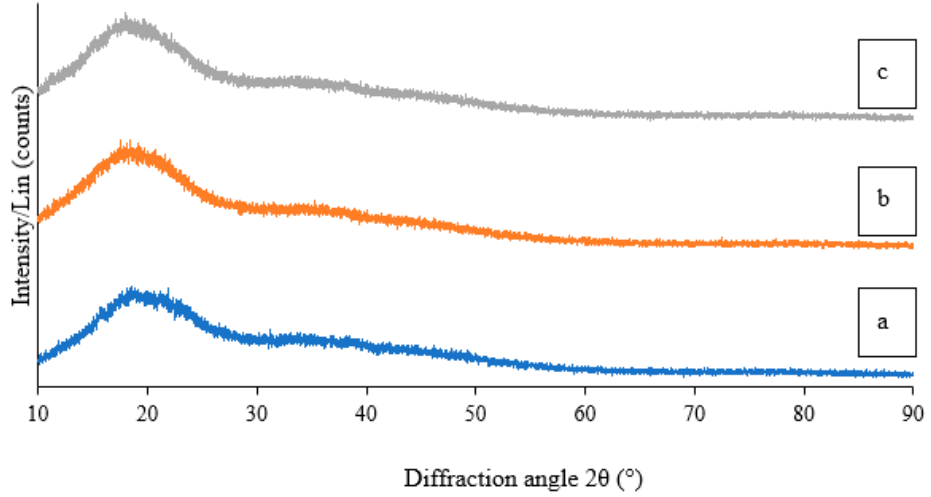
Figure 3. The image shown is an XRD spectrum of ( a ) C2, ( b ) C10, and ( c ) C16 in their amorphous